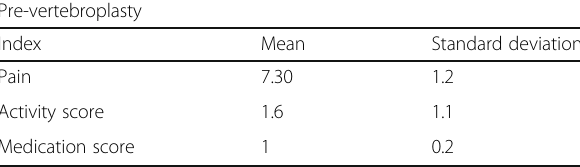
Table 1 Pain score, activity score and medication score